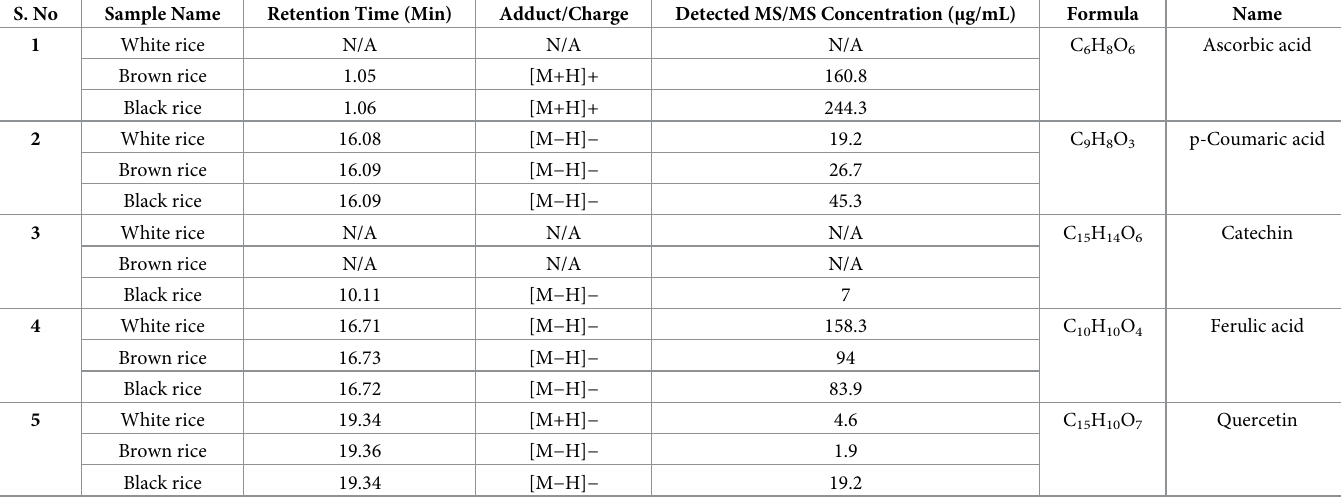
Table 2. Quantification of phytochemicals discovered in the free fractions of white, brown and black rice by UHPLC-Q-TOF-MS 2 . S.